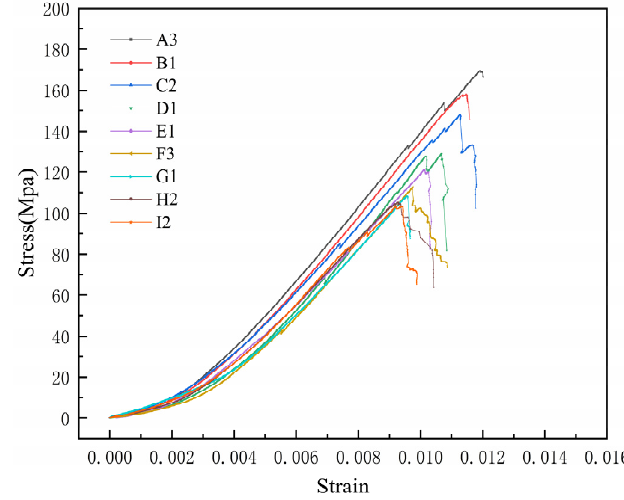
Figure 4. Stress–strain curve of specimens with different moisture content.